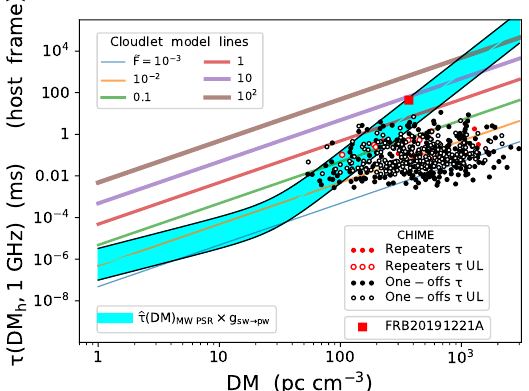
Figure 1. Figure 5 from [42], “Redshift Estimation and Constraints on Intergalactic and Interstellar Media from Dispersion and Scattering of Fast Radio Bursts”, reproduced with permission from Jim Cordes, published by ApJ (IOP Publishing), 2021. It shows the expected scattering time vs DM from the galactic relation derived for pulsars (cyan shaded region, from [38]). The dots represent all published FRBs from CHIME [14]: black dots represent one-off FRBs, red dots represent repeaters and the empty dots in both colors represent upper limits on scattering. The red square represents the extremely scattered FRB20191221A